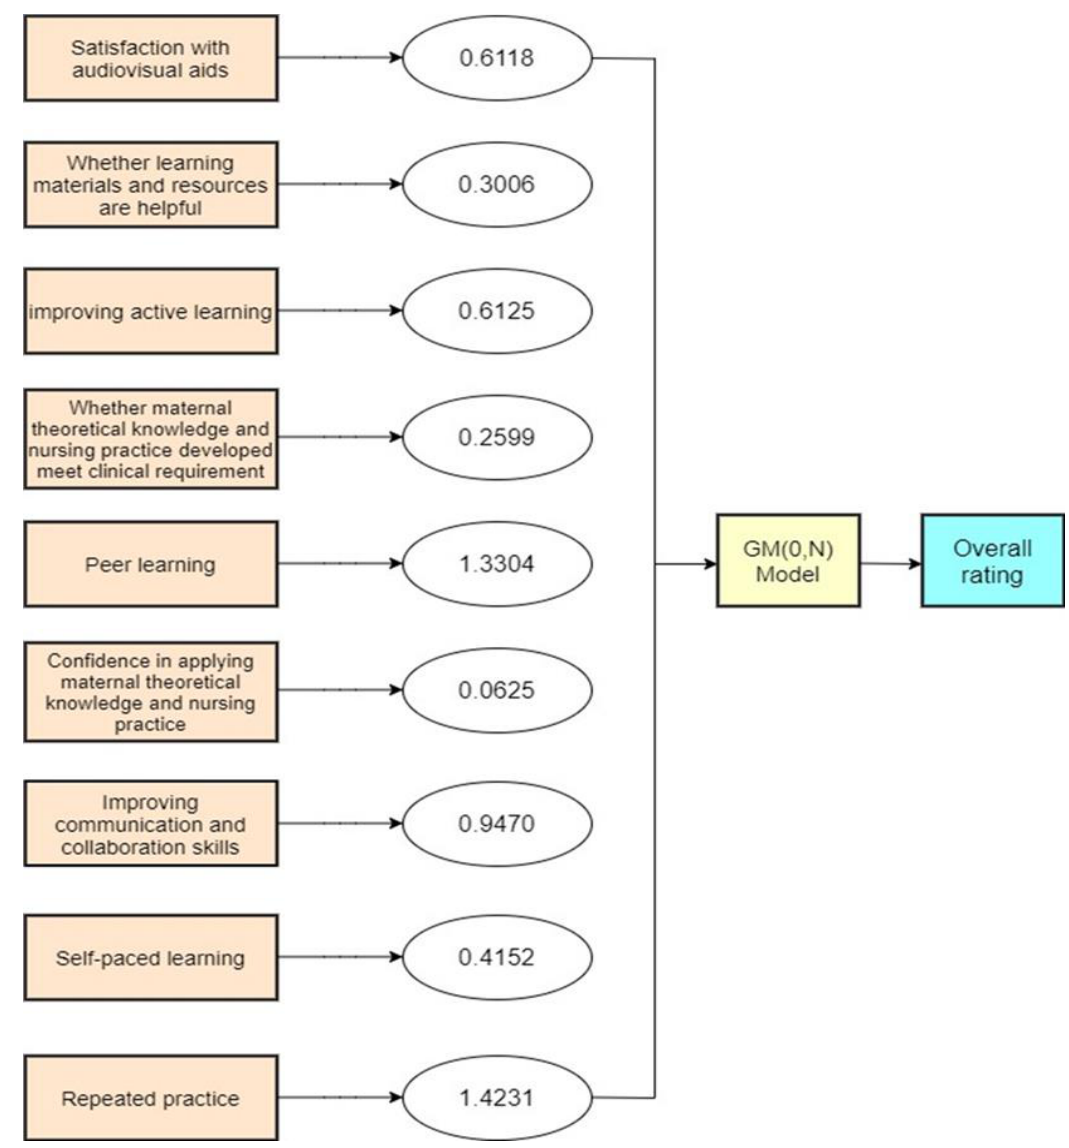
Figure 1. Grey Model (GM) (0, N) the significance of nine factors .